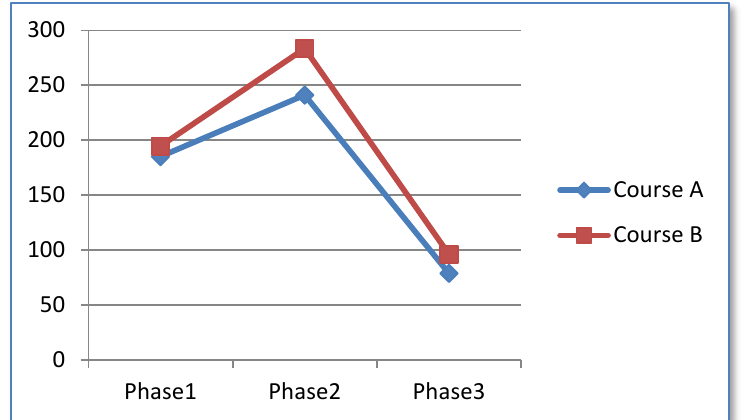
Figure 10. Average score in each phase for the two courses.